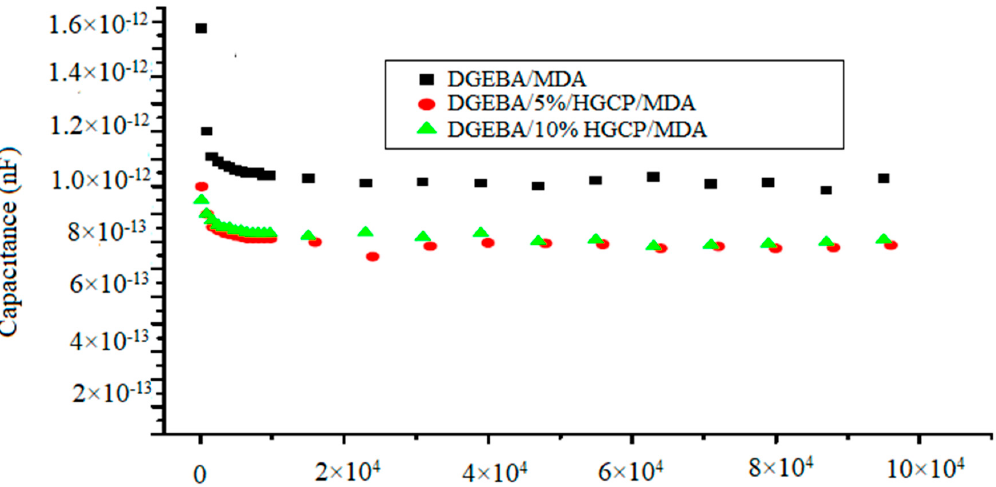
Figure 8. Capacity-frequency characteristics for DGEBA samples with di ff erent quantities of HGCP (0%, 5% and 10%).